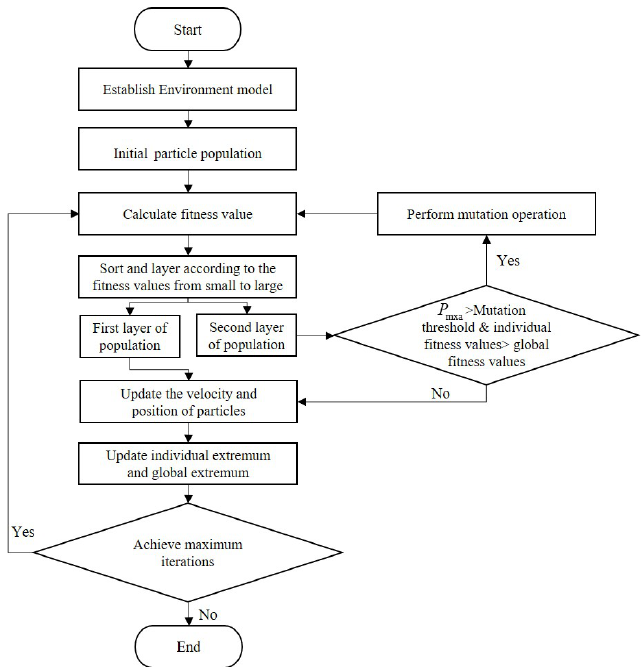
Figure 3. The improved SPSO-2011 algorithm flow